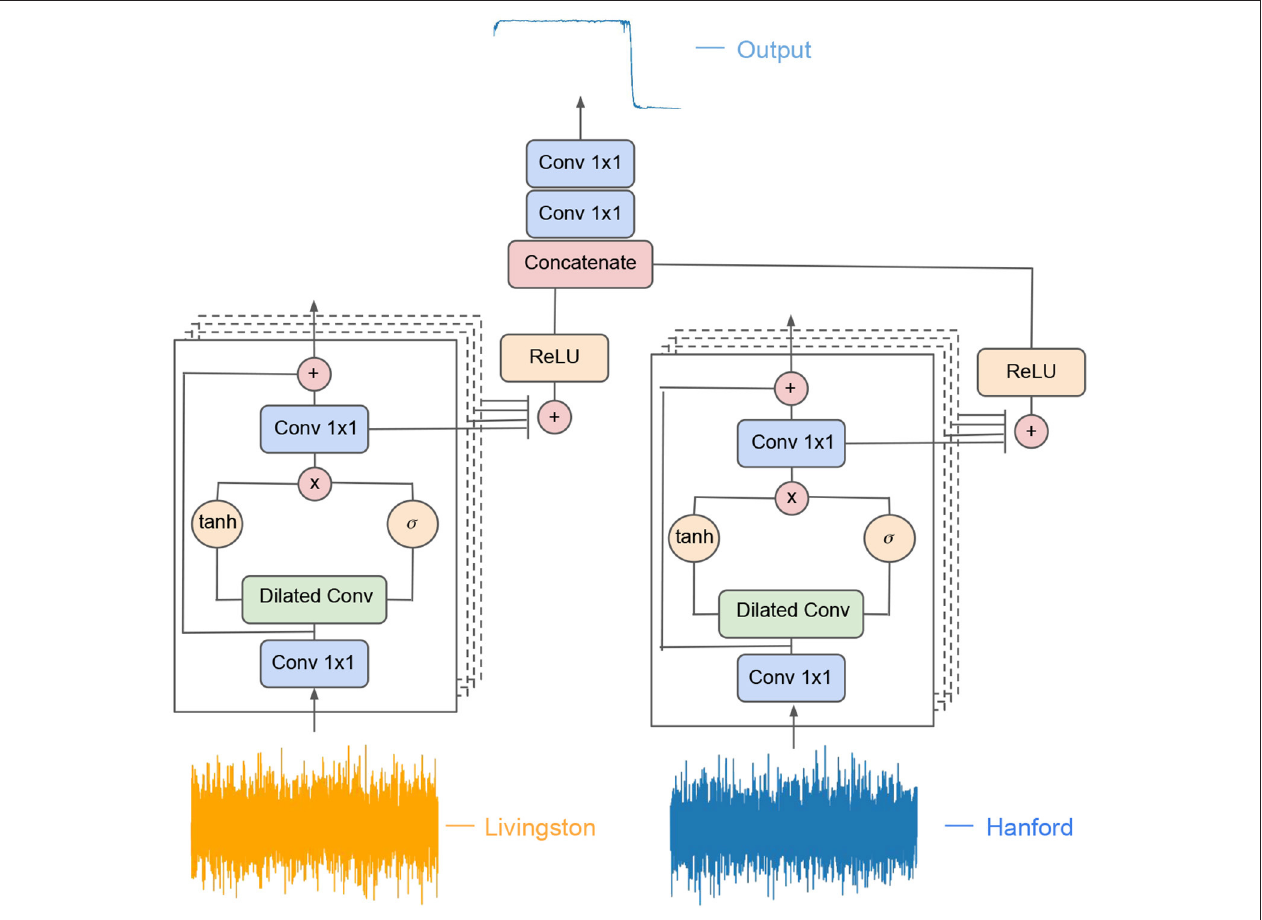
FIGURE 1 | AI architecture. Modified WaveNet model used for gravitational wave detection. Each branch processes concurrently one of the two advanced LIGO data streams—Hanford or Livingston. The output of the two branches is then concatenated and fed into a pair of convolutional layers whose output indicates at each time step whether the input advanced LIGO data contains “noise” or a